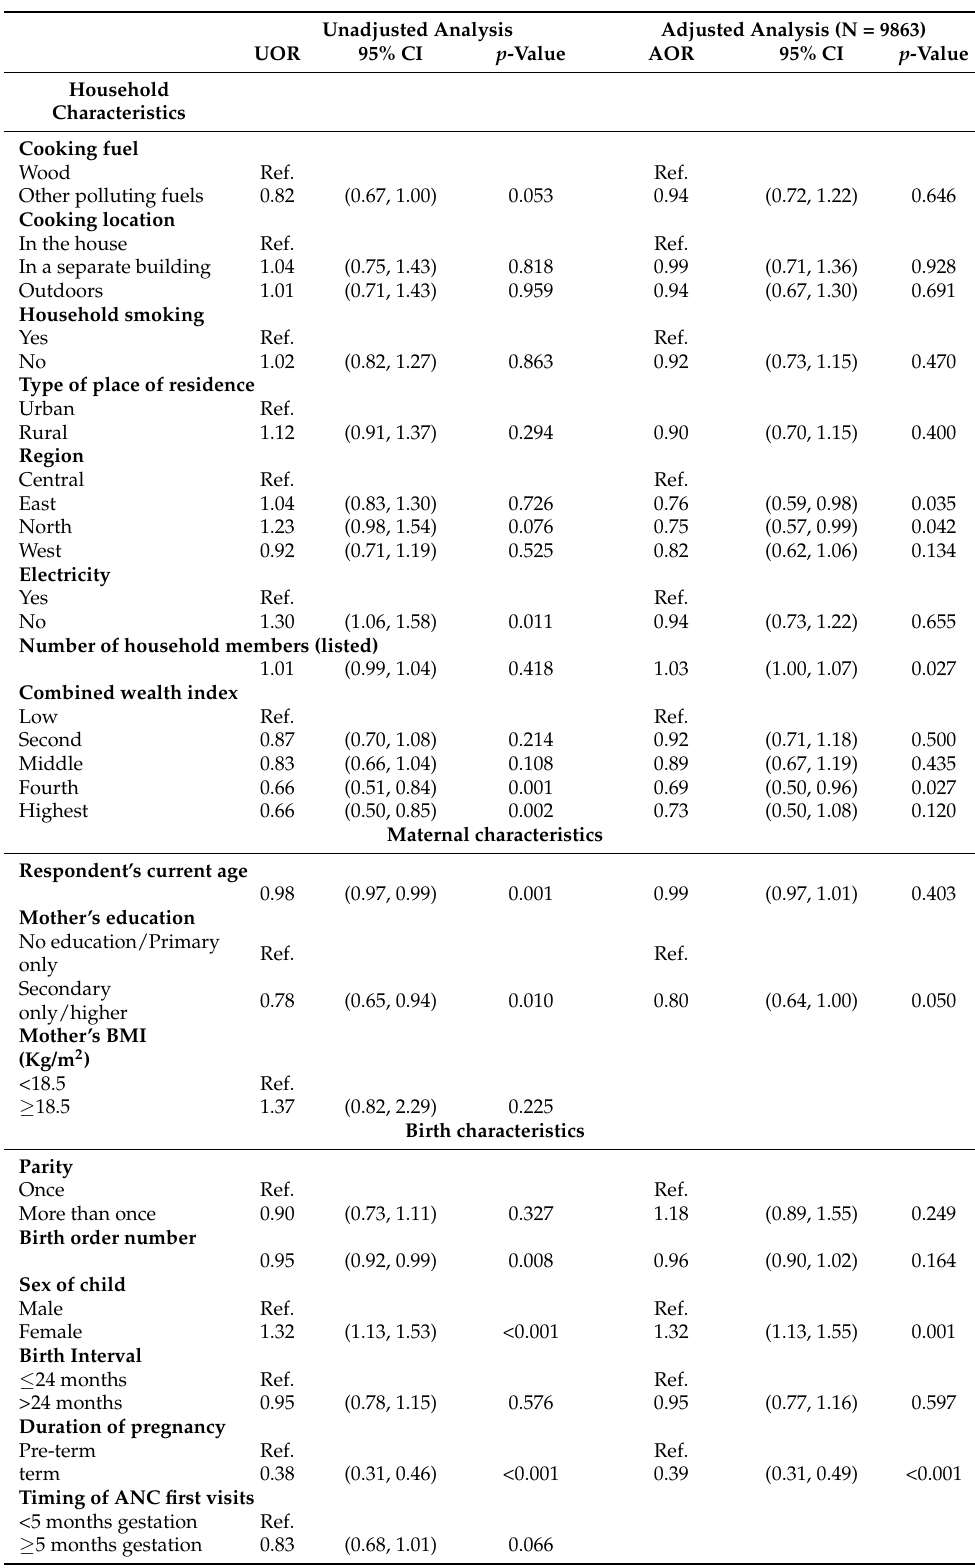
Table 3. Unadjusted and adjusted analysis for the association between LBW and type of biomass cooking